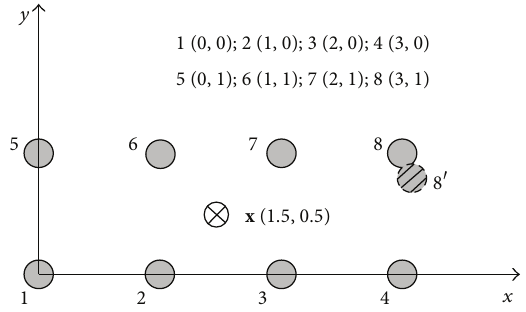
Figure 1: An example with eight nodes and their